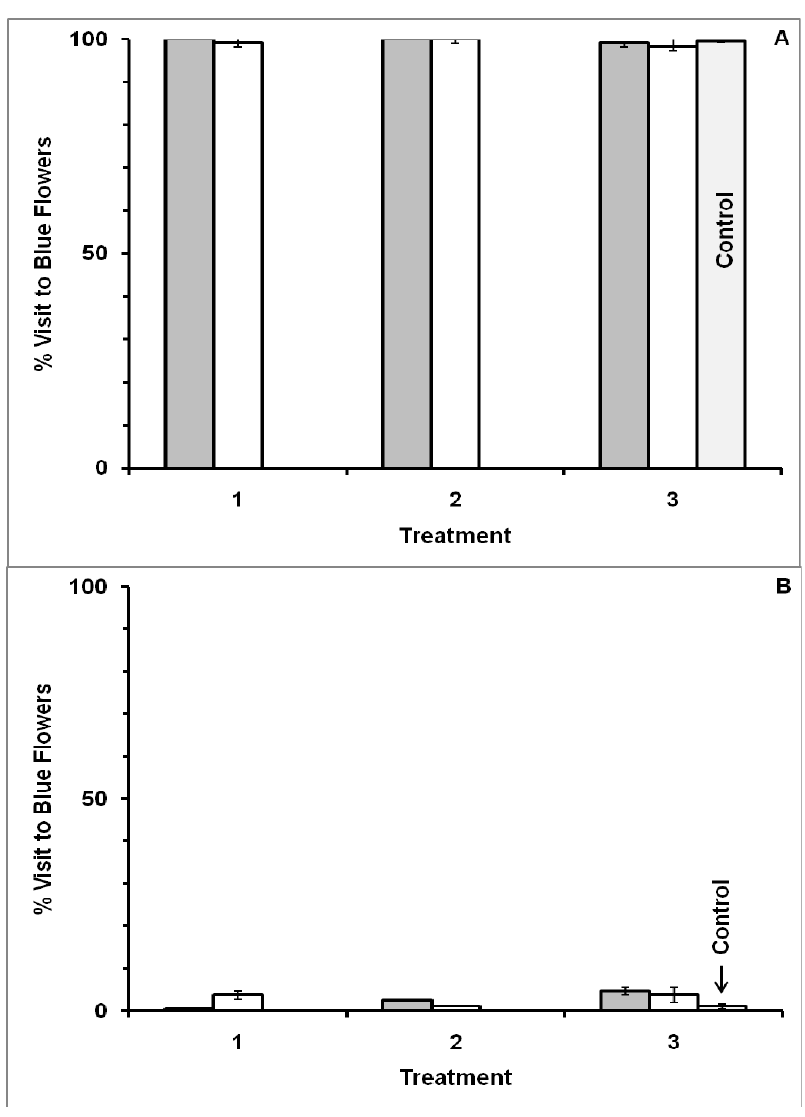
Figure 3. Visitation by bees to blue-yellow dimorphic flower patches in Experiment I. Reward odor, site location and time differed between morning and afternoon flower patches. Percentage of blue flowers visited is presented for blue forager-type bees in Panel ( A ) (N = 7 bees), and for yellow forager-type bees in Panel ( B ) (N = 7 bees). Error bars indicate ±1 SE. Bar color is by flower color offering the higher molar sucrose reward in Treatment 2: gray bars = bees given the higher molar reward in blue flowers, and white bars = bees given the higher molar reward in yellow flowers. Treatment 1: morning patch, flat flowers with clove scent, with both blue and yellow flowers offering the same reward. Treatment 2: morning patch, flat flowers with clove scent, with reward difference between blue and yellow flowers. Treatment 3: afternoon patch, flat flower with peppermint scent, with both blue and yellow flowers offering the same reward. Control represents bees that had never visited the morning patch, and thus never experienced Treatments 1 and 2 (N = 11